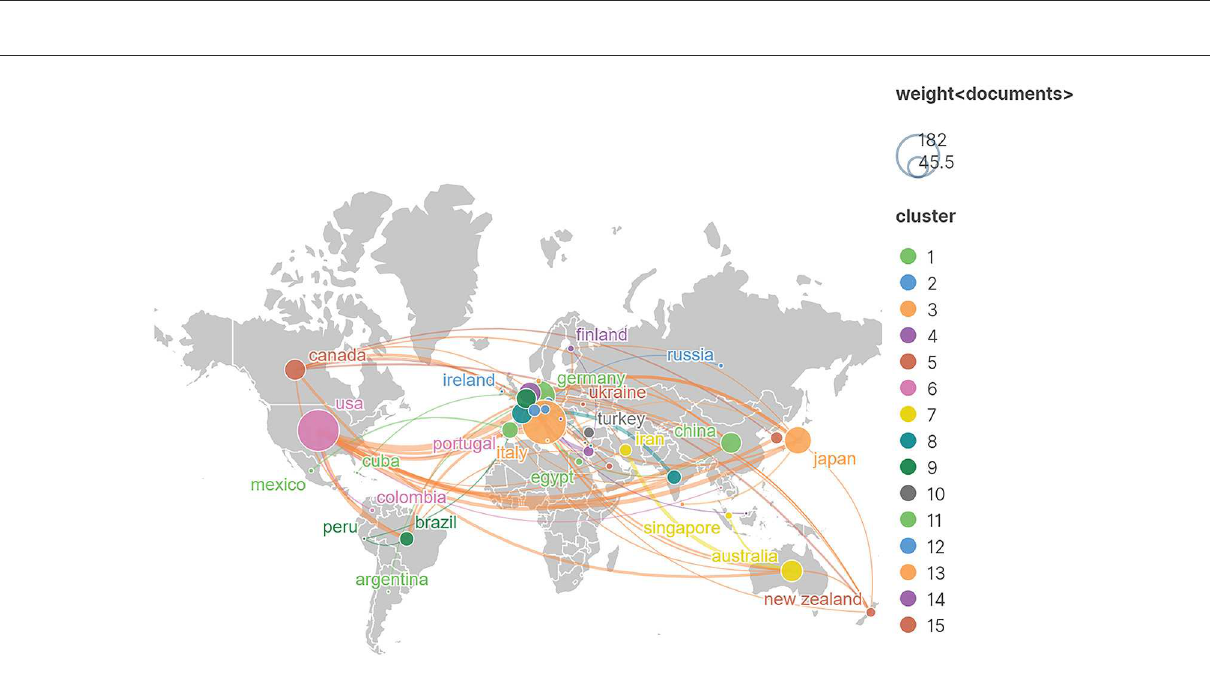
FIGURE4 The co-authorship network visualisation map of countries in non-invasive cerebellar stimulation research. In the network map, a node represents a country, and node size indicates the number of publications. A line between two nodes associates with the cooperation